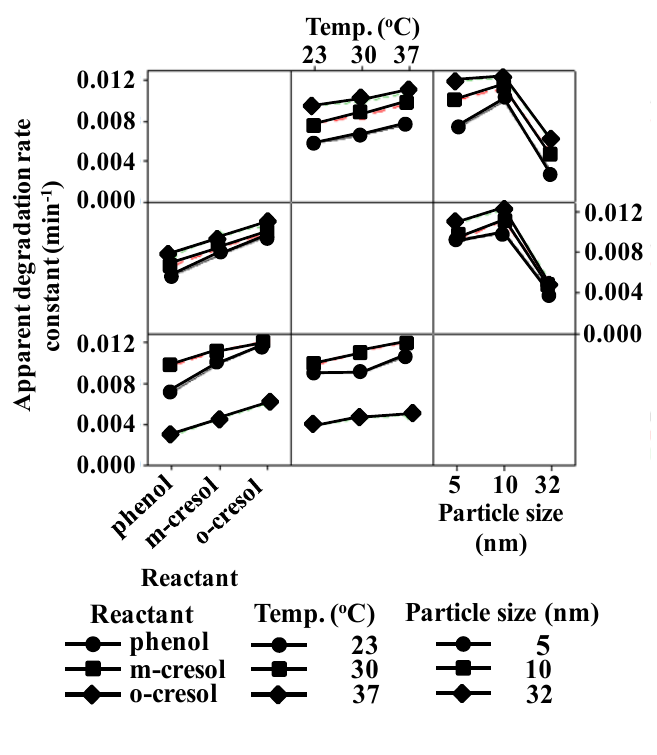
Figure 6. Interaction plots for experimental response data.